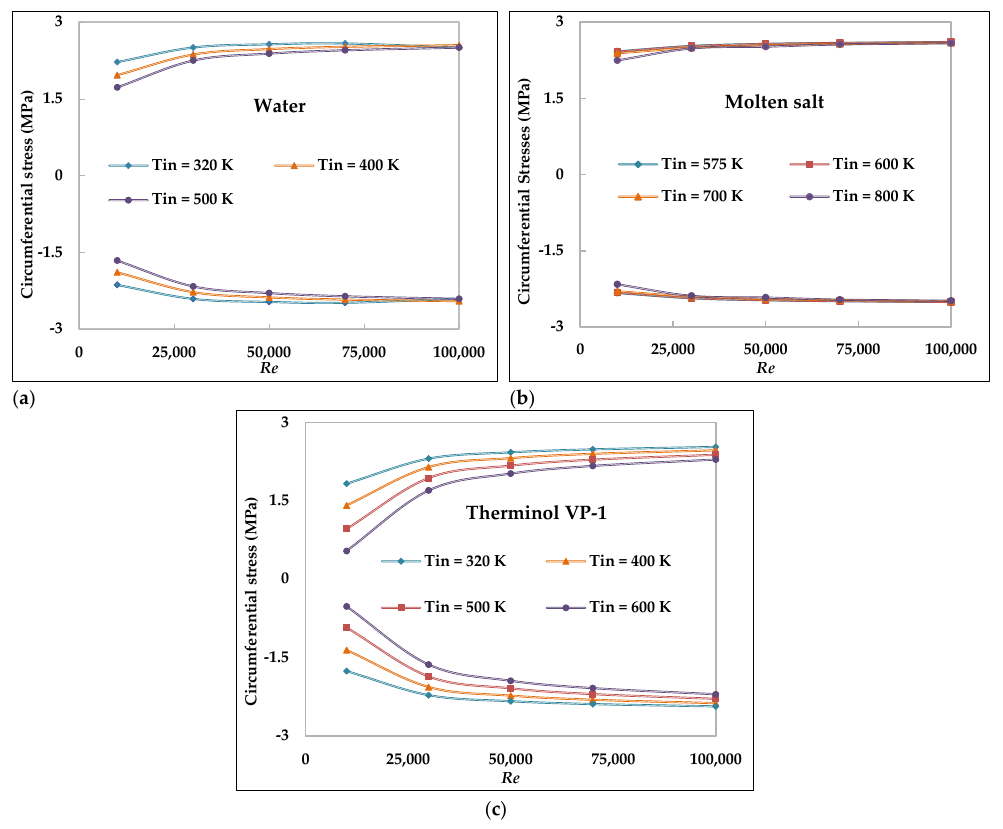
Figure 11. Thermal stresses distributions of all working fluids at different inlet fluid temperatures.